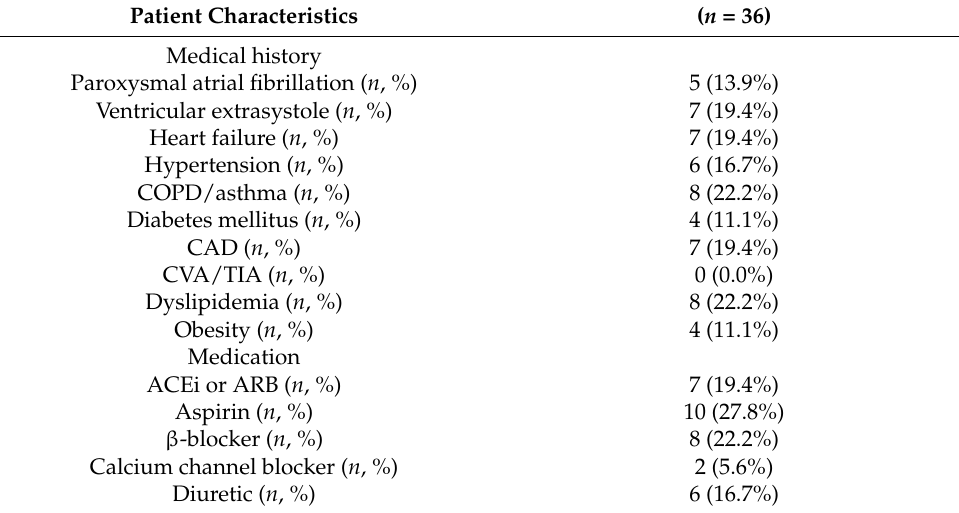
Table 2. Baseline clinical characteristics of the patients (group 2).